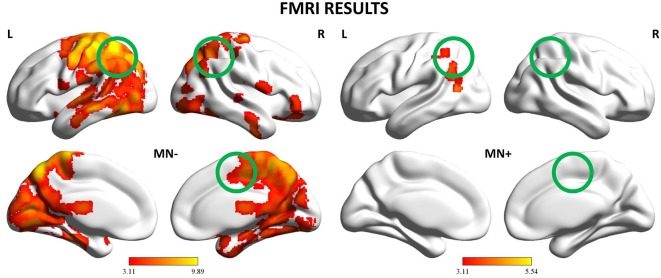
fMRI results: Whole-brain analysis. Activation maps for the 2 patients (MN−, MN+) relative to the contrast Bimanual vs. Unimanual actions (CL + LL > L + C). The activation maps are mapped on the lateral and medial views of a MNI template brain at p < 0.001 uncorrected. The color bar refers to t-values. The position of the tested ROIs are highlighted with circles. MNI coordinates: pre-supplementary motor area (pre-SMA) (4, −2, 52), left posterior parietal cortex (PPC) (−37, −50, 33), right PPC (26, −44, 36).